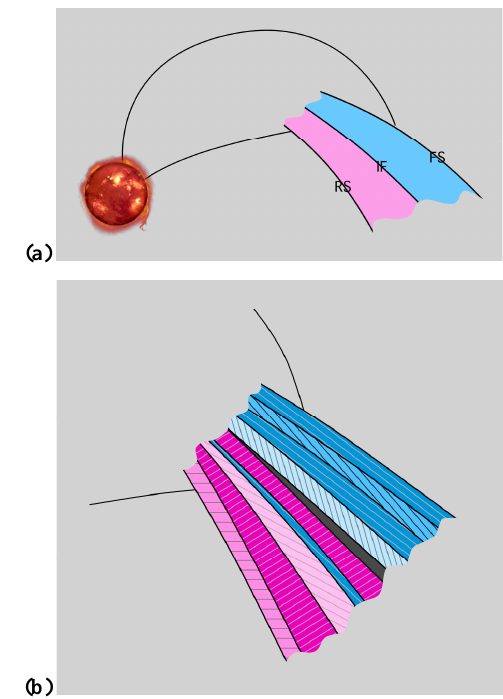
Fig. 7. Schematics showing the geometry of a CIR, the upstream Figure 7b and downstream interplanetary magnetic fields and the forward and reverse shocks (panel a ). Panel b shows a more realistic plasma beta distribution of the CIR. This is due to variations of the upstream and downstream magnetic field